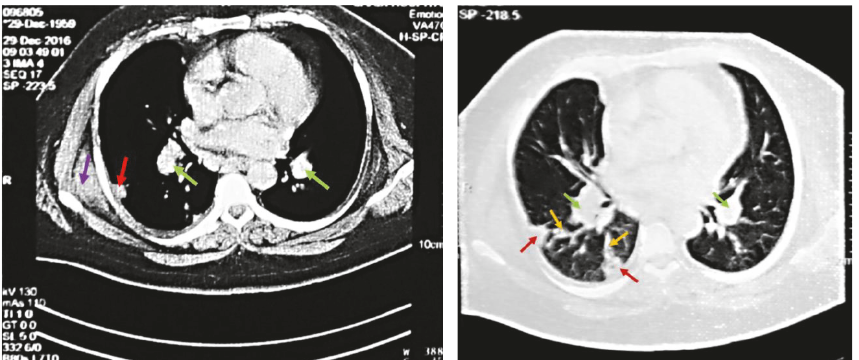
Figure 3: CT of Chest. Lung lesions. Hilar adenopathies (green arrows), probable septic embolization (red arrows), feeding vessels (yellow arrow), and serratus anterior muscle (purple